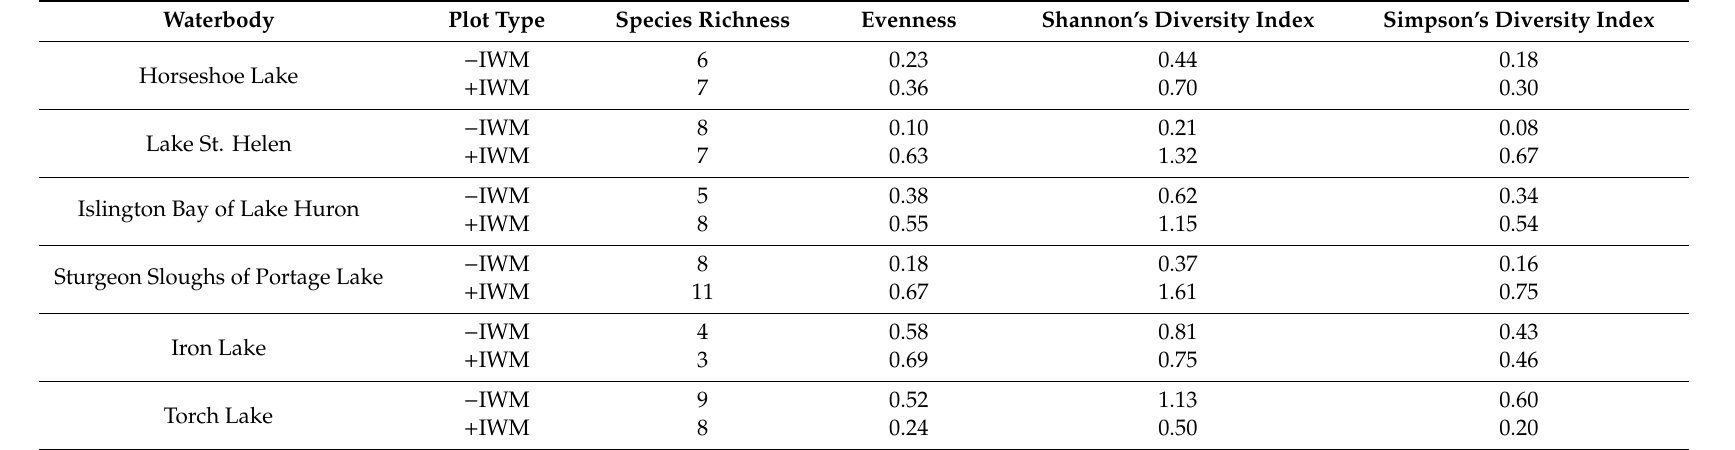
Table A2. Diversity indices of the macrophyte assemblages in paired + IWM and − IWM